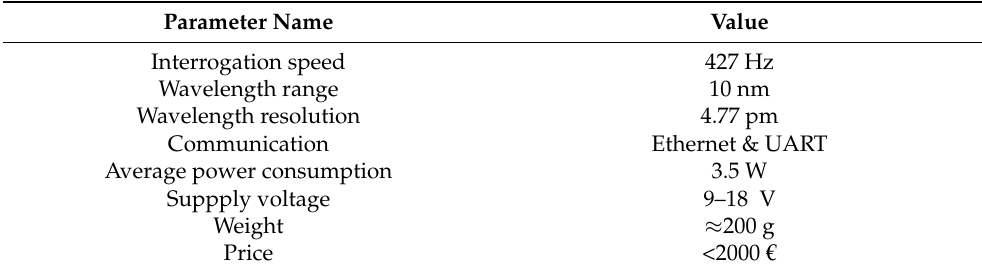
Table 2. Parameters of the proposed interrogator